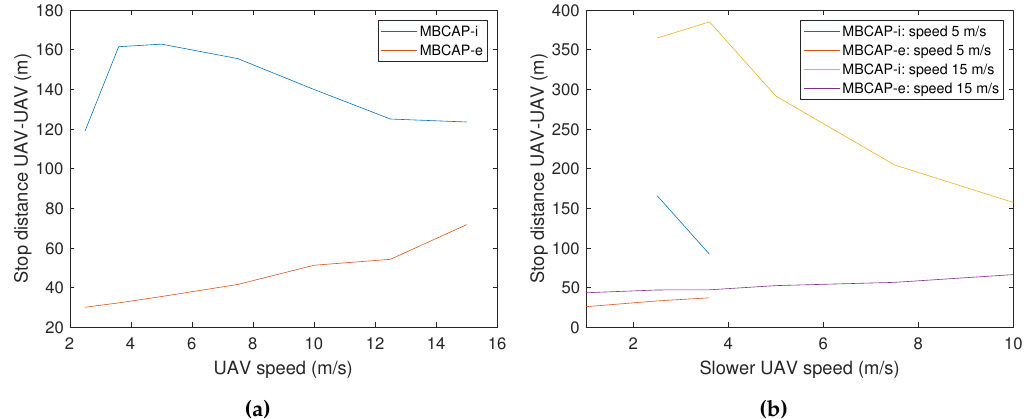
Figure 5. Distance between UAVs after stopping, in a face-to-face meeting. ( a ) UAVs flying at the same speed. ( b ) UAVs flying at different speeds.